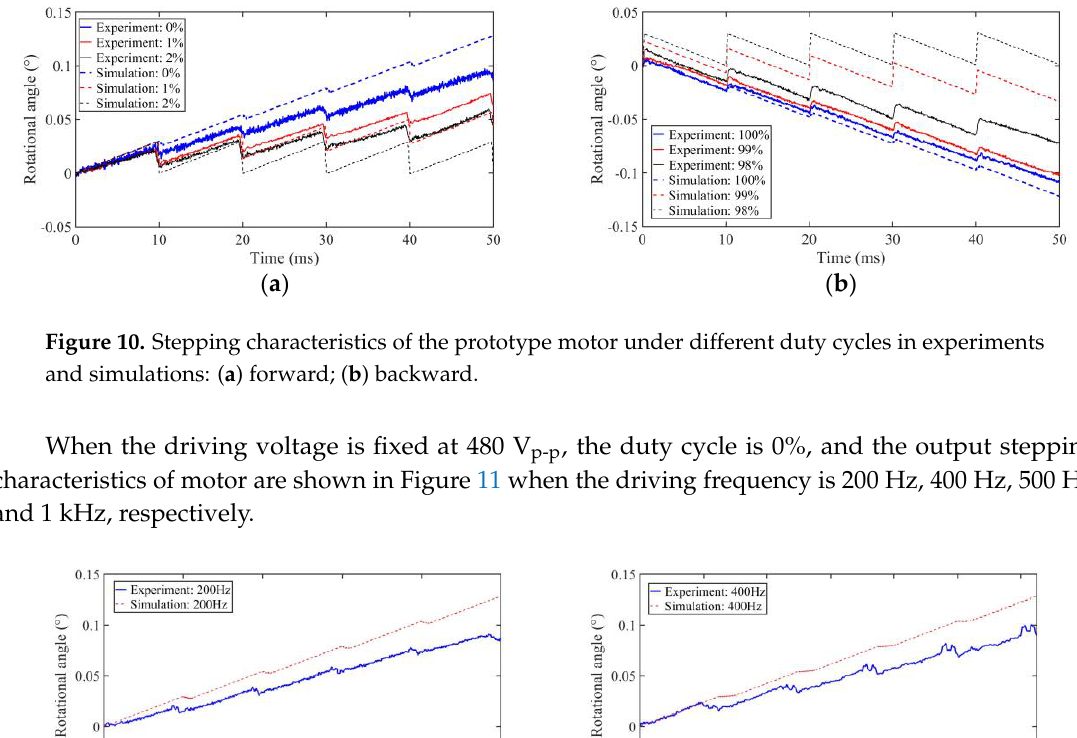
Figure 10. Stepping characteristics of the prototype motor under different duty cycles in experiments and simulations: ( a ) forward; ( b ) backward.